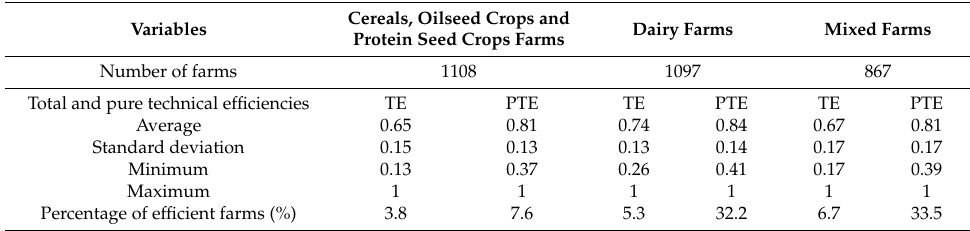
Table 5. Total technical efficiency (TE) and pure technical efficiency (PTE) of the three types of farms calculated under technology T1.